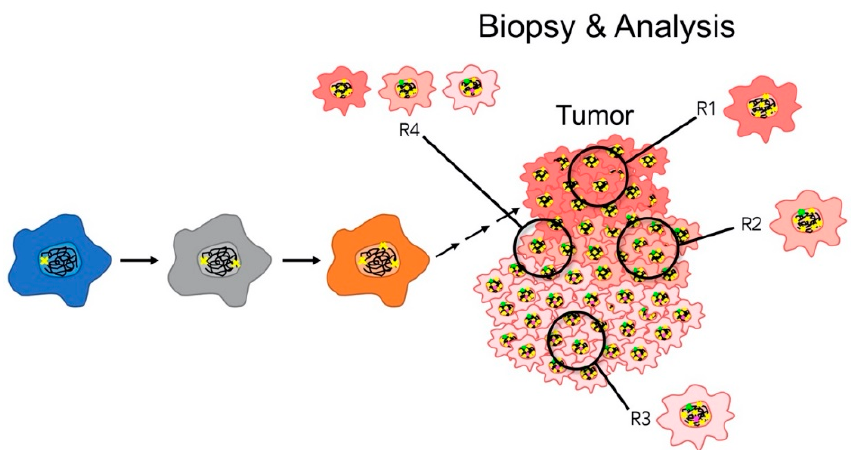
Figure 3. Impact of CIN on regional biopsies and subsequent analyses. A schematic showing how CIN (represented by arrows) induces genetic diversity (colored ‘x’) within a given tumor (represented by color changes). Note that the ability to glean tumor-specific insight (trunk versus branch alterations) into the aberrant genetics driving tumor development and progression is impacted by regional sampling and the composition and clonality of the tumor cells contained within the biopsied region. Single region bias is demonstrated by the four distinct regions (R1–4), which exhibit variation in both the type of clones identified (R1–3) and in the composition (presence and frequency) of the clones (R4) contained within a given biopsy.